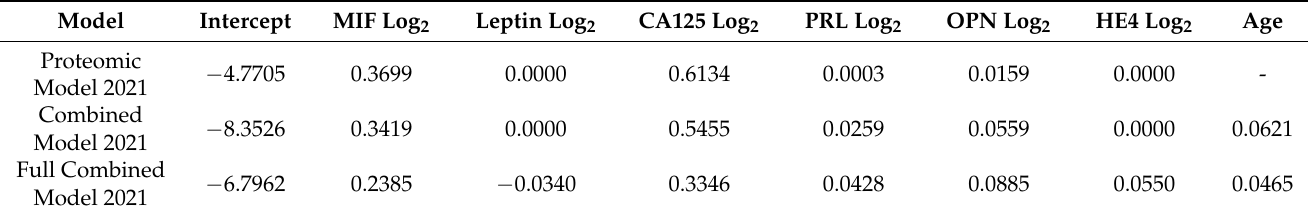
Table A3. Selection of variables for model development: regression coefficients.